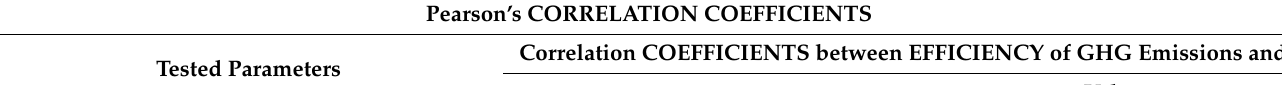
Table 7. Pearson’s correlation coefficients between efficiency of GHG emissions in agriculture in the EU countries and economic and energy efficiency and productivity of energy consumption in EU